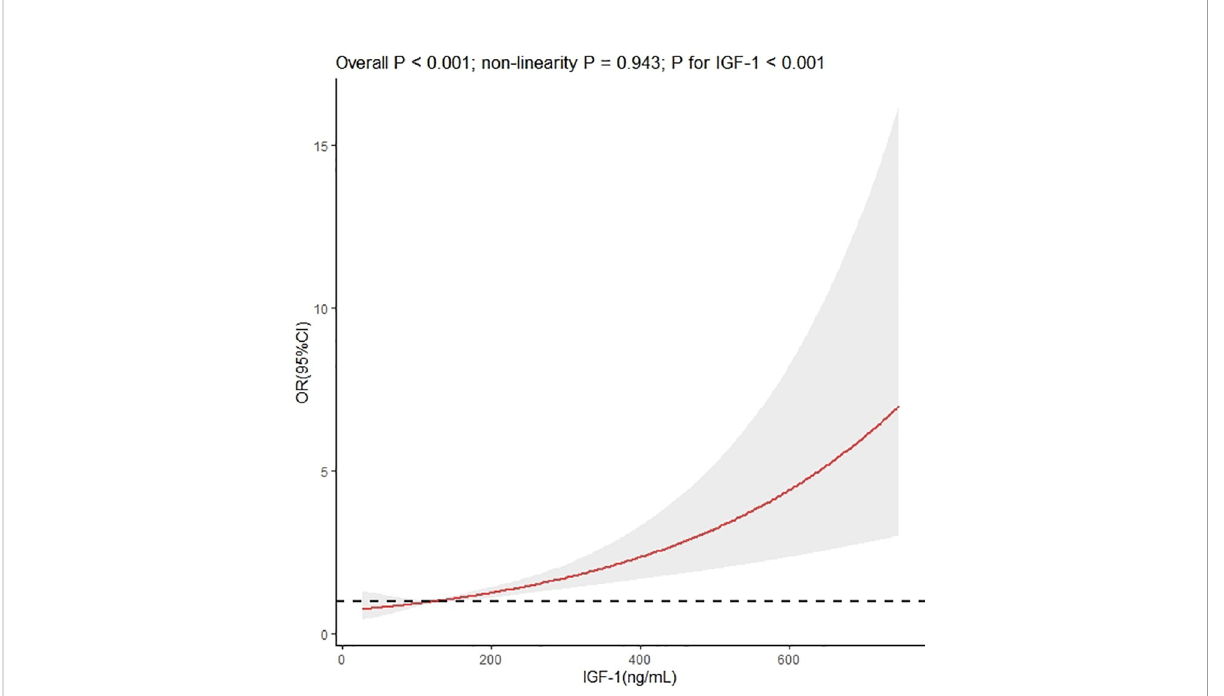
FIGURE 3 Dose – response association between insulin-like growth factor-1 and interventricular septal thickening according to restricted cubic splines. The asterisk means adjusted for propensity